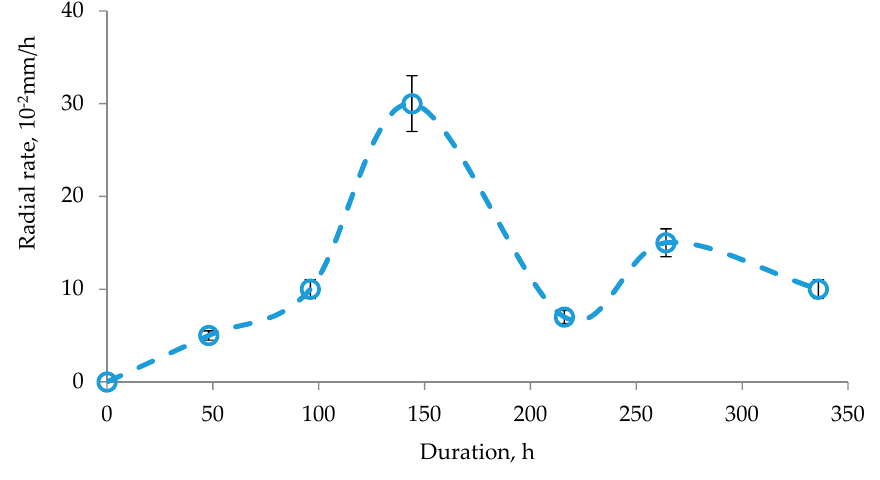
Figure 1. A. niger growth curve .